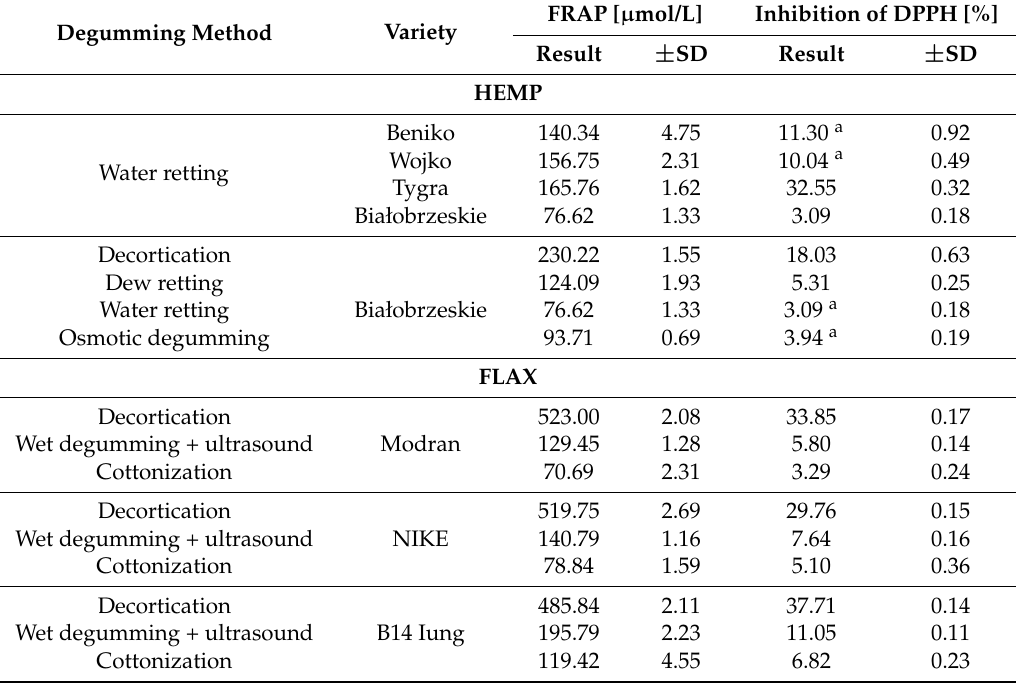
Table 3. The antioxidative activity of different varieties of bast fibers depending on the extraction method. Results are expressed as mean ± standard deviation (SD), n = 3. Lower-case letters indicate significant differences at p ≤ 0.05 according to the Tukay’s HSD